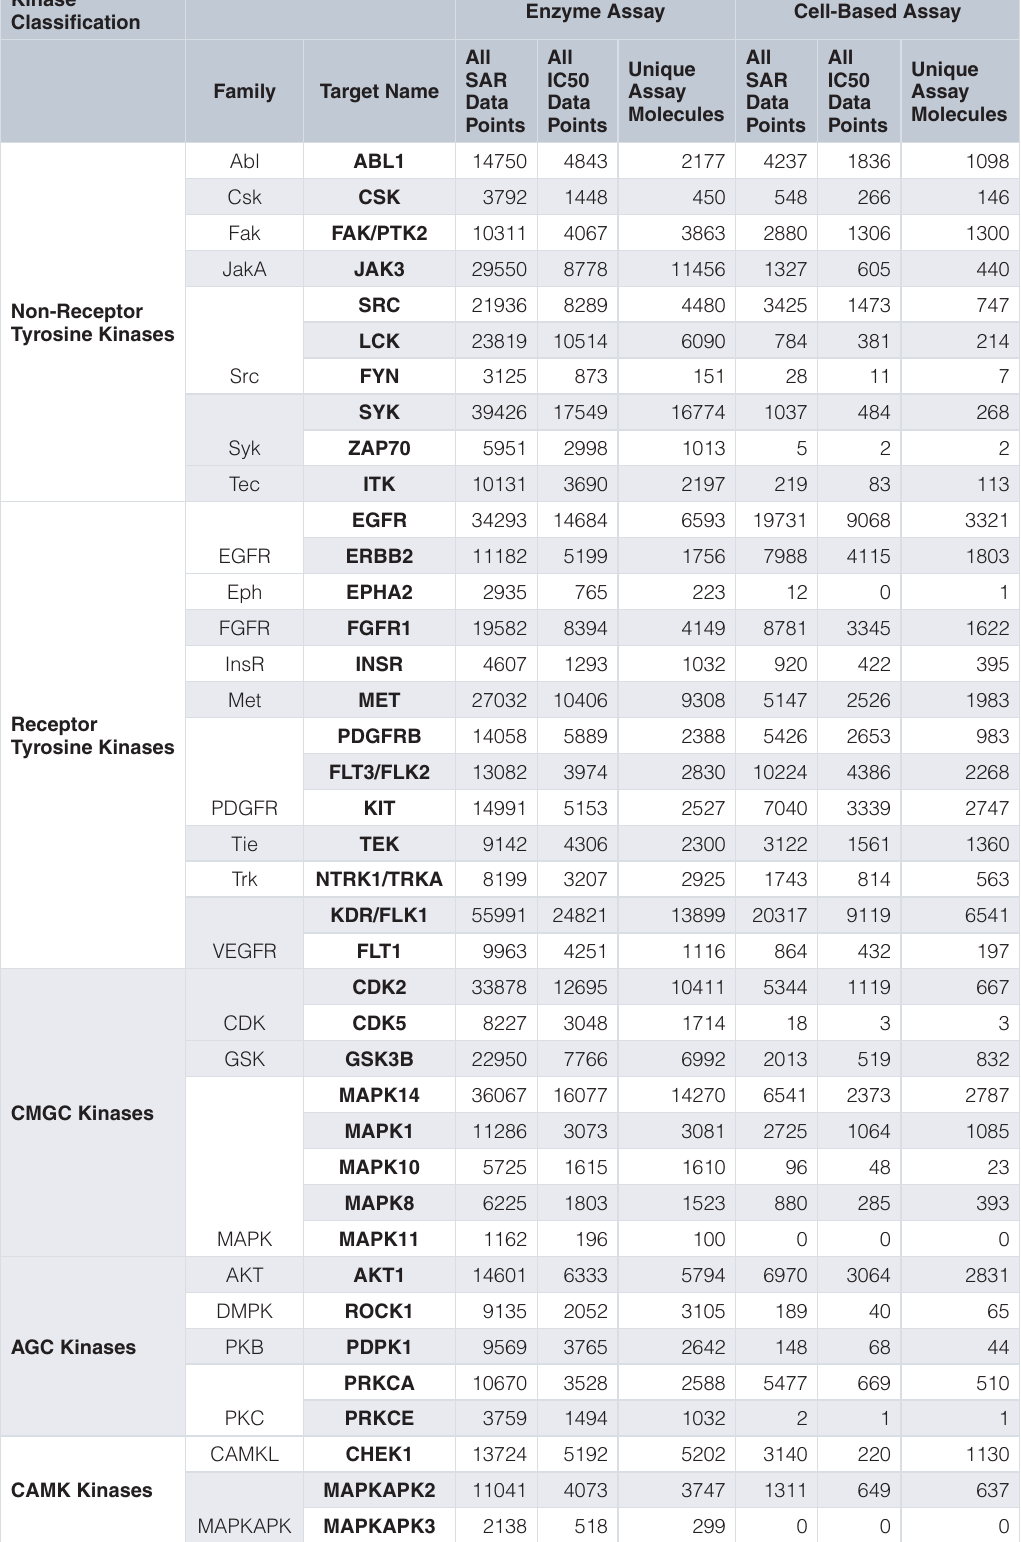
Table 2. Eidogen-Sertanty Kinase Knowledgebase. Data Points for Selected Targets– Q1 2016 Release. Kinase Classification